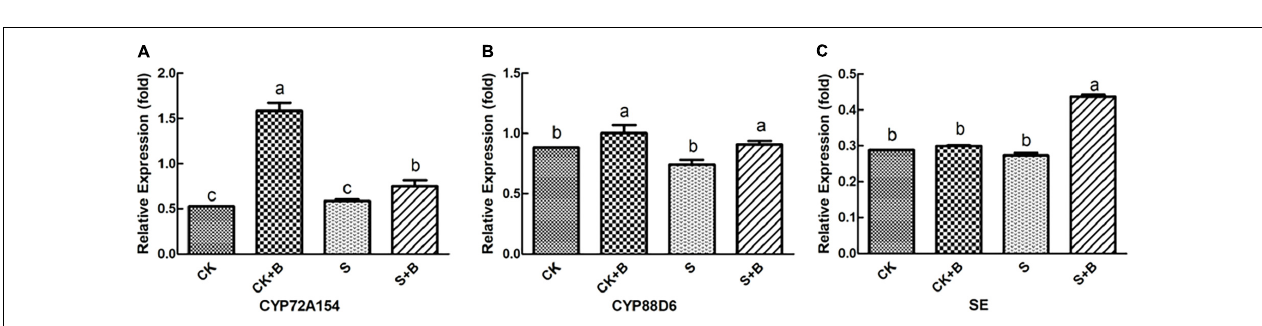
FIGURE 6 | Effect of B. cereus on expression level of (A) HMGR, (B) β -AS, (C) SQS, (D) CHS, (E) LUS, and (F) UGAT genes of G. uralensis under control (CK) and salt stress (S) conditions. Data are expressed as the mean ± SE ( n = 6). The different letters within the different treatments indicate the significant difference at P < 0.05.